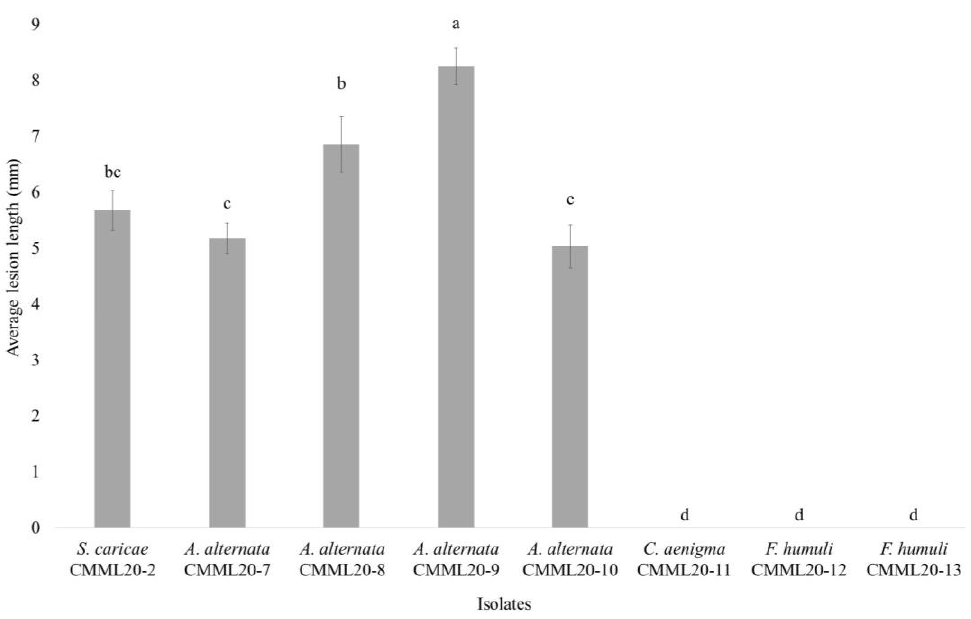
Figure 7. Lesion length produced by fungal isolates on beach vitex detached leaves. The A. alternata isolates and S. caricae CMML20–2 showed significant lesion development compared to C. aenigma CMML20–11 and F. humuli isolates. Bars and error bars represent means and standard errors of length of lesion formed by the isolates (n = 9). Different letters above bars indicate statistically significant difference of the means.